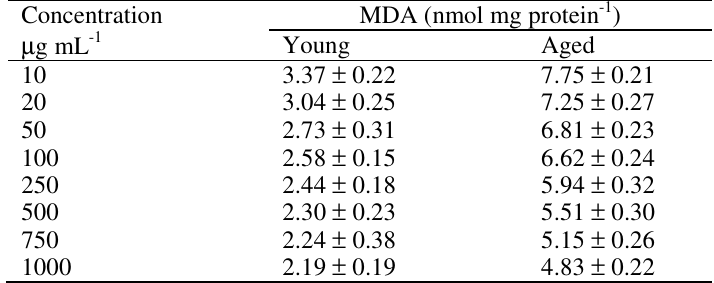
Table 2. Activity of ethanol extract of Cyperus rotundus rhizomes at different concentrations on ferrous sulphate induced lipid peroxidation in young and aged rat brain